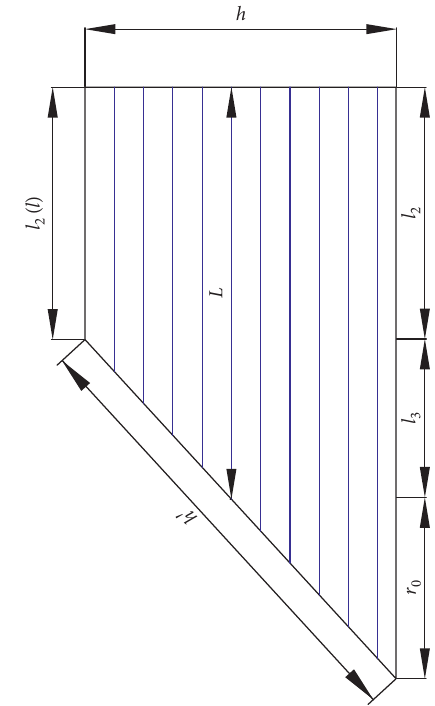
Figure 4: Simplification of the seepage path in the